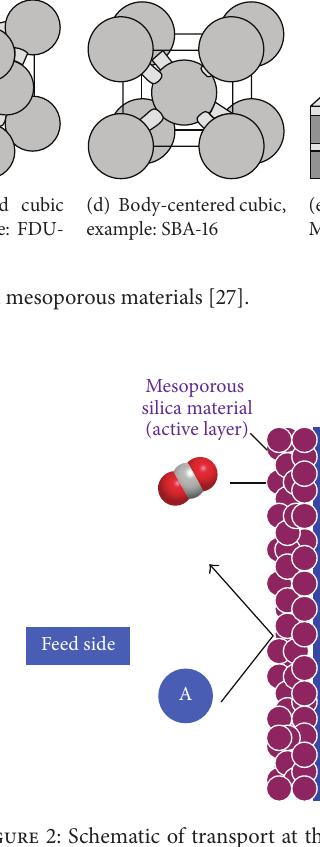
Figure 2: Schematic of transport at the molecular level through a supported asymmetric mesoporous silicas membrane. CO 2 is the permeating gas, and A is the retentate gas